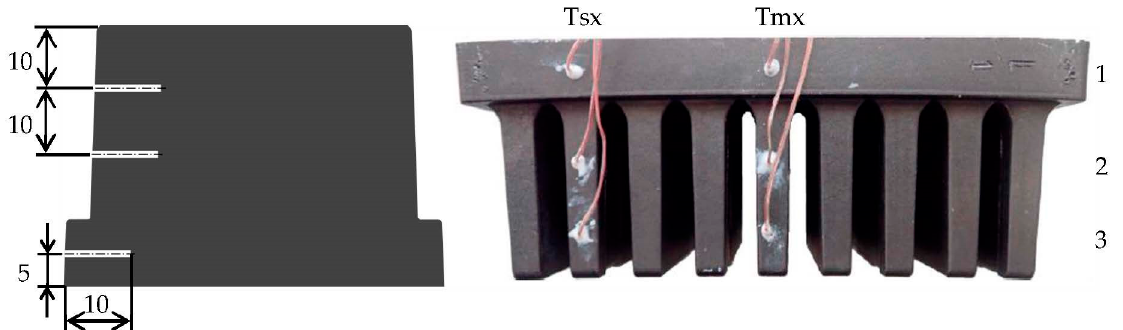
4 of 17 Figure 2. Measurement box inside the thermostatic chamber with attached thermal imaging camera ( left ), heat sink inside the measurement box ( middle ), attached heater with the thermocouple on